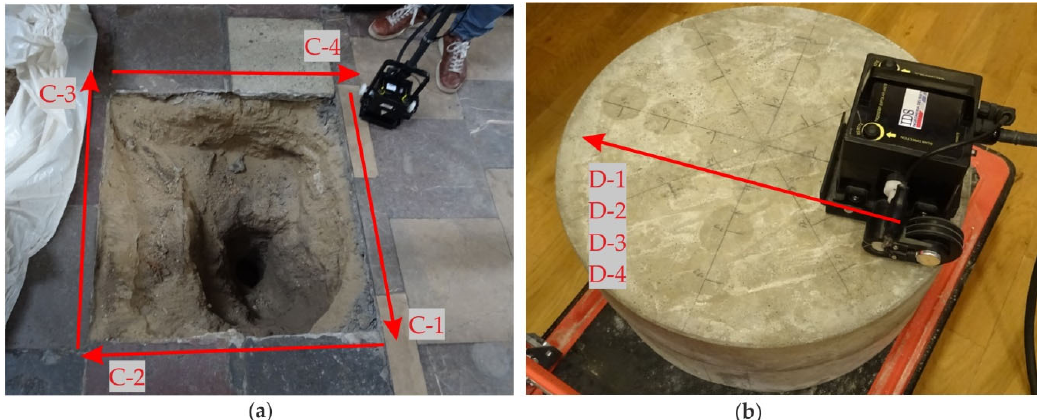
Figure 7. GPR traces registered along ( a ) edges of the trial pit (traces C ‐ 1 to C ‐ 4) and ( b ) the circular slabs with air gaps of varying thickness (traces D ‐ 1 to D ‐ 4).